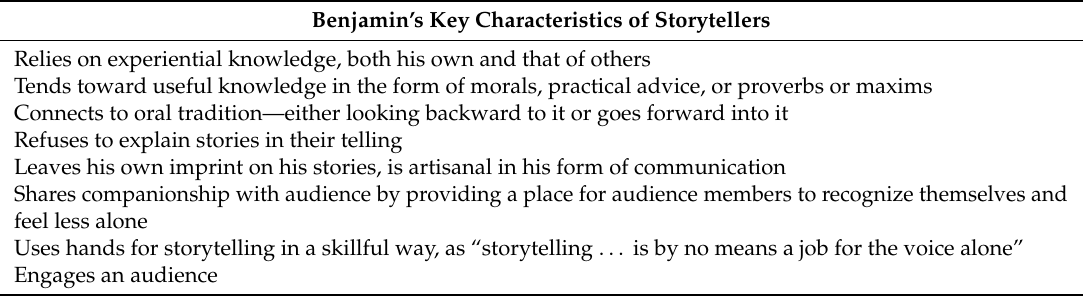
Table 1. Benjamin’s key characteristics of